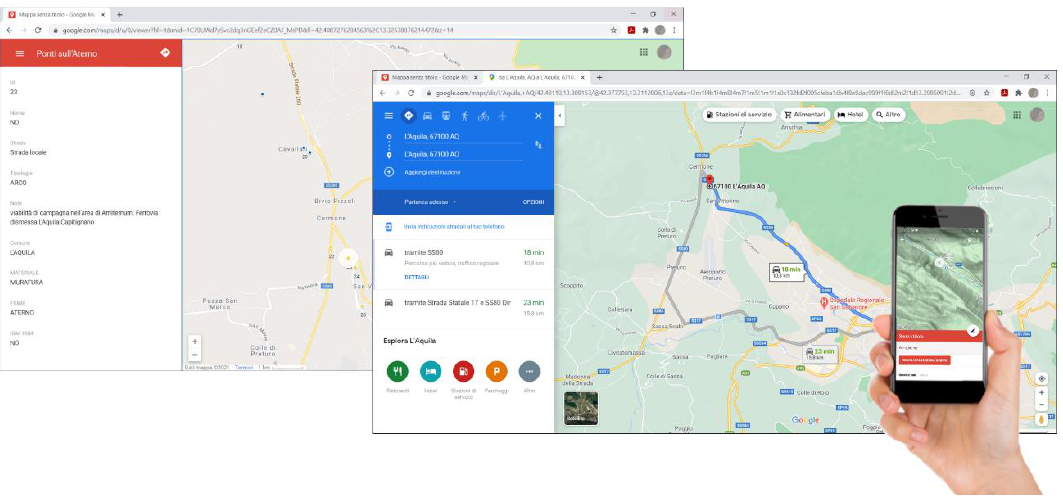
Figure 5. Census exported in KML format and usable on My Maps in desktop and mobile mode.